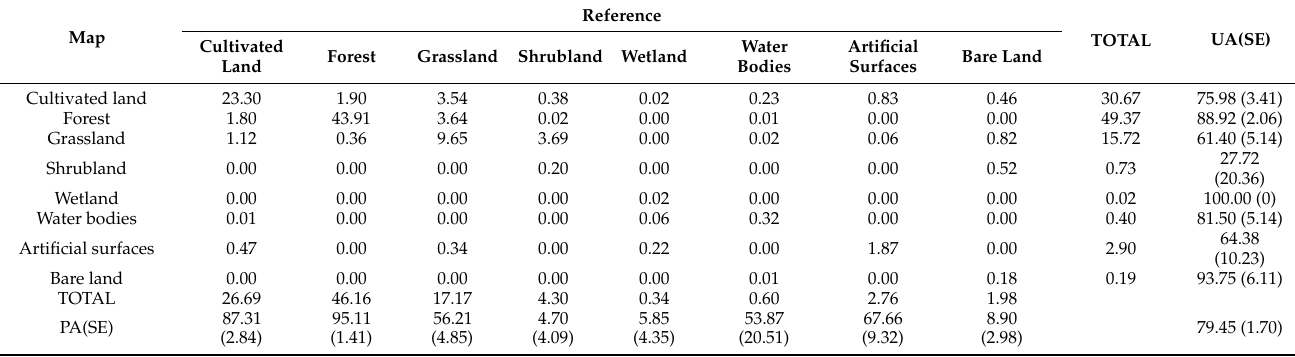
Table A14. Error matrix of fused product 2020 using consensus-based method.